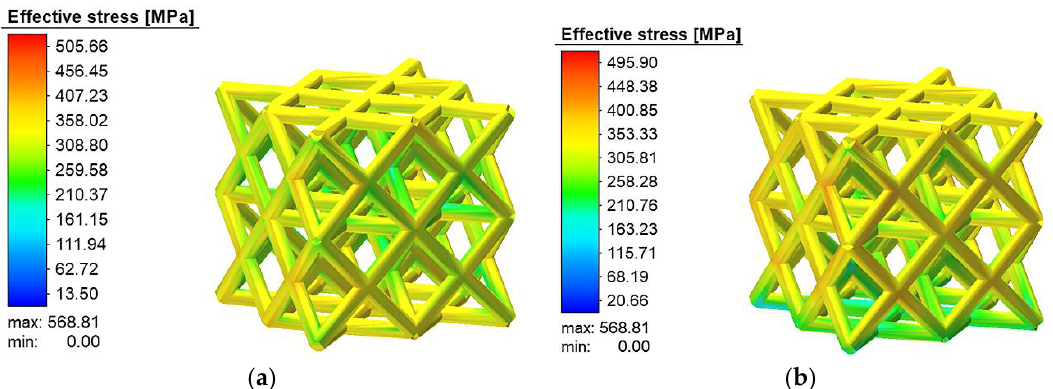
Figure 10. Distribution and magnitude of residual stress within the FCC structure: ( a ) before substrate removal, ( b ) after substrate removal.